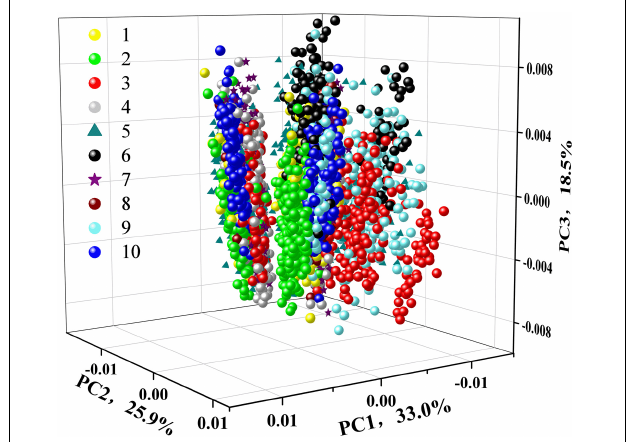
FIGURE 4 | 3D scatter plot of 10 different varieties of soybeans based on the first three principal components (PCs).